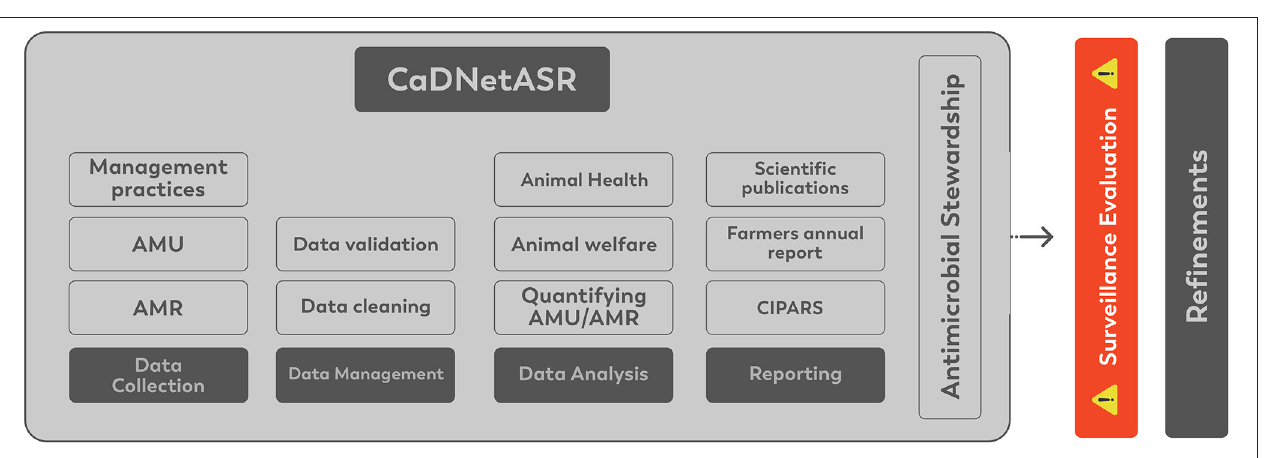
FIGURE 2 | CaDNetASR surveillance system